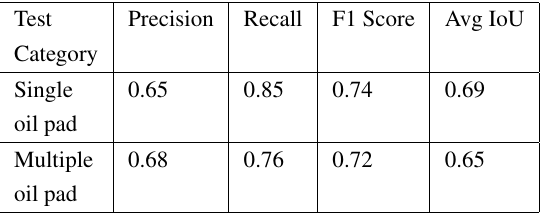
Table 4. Precision, recall, F1 score and average IoU for single and multiple oil pad set.